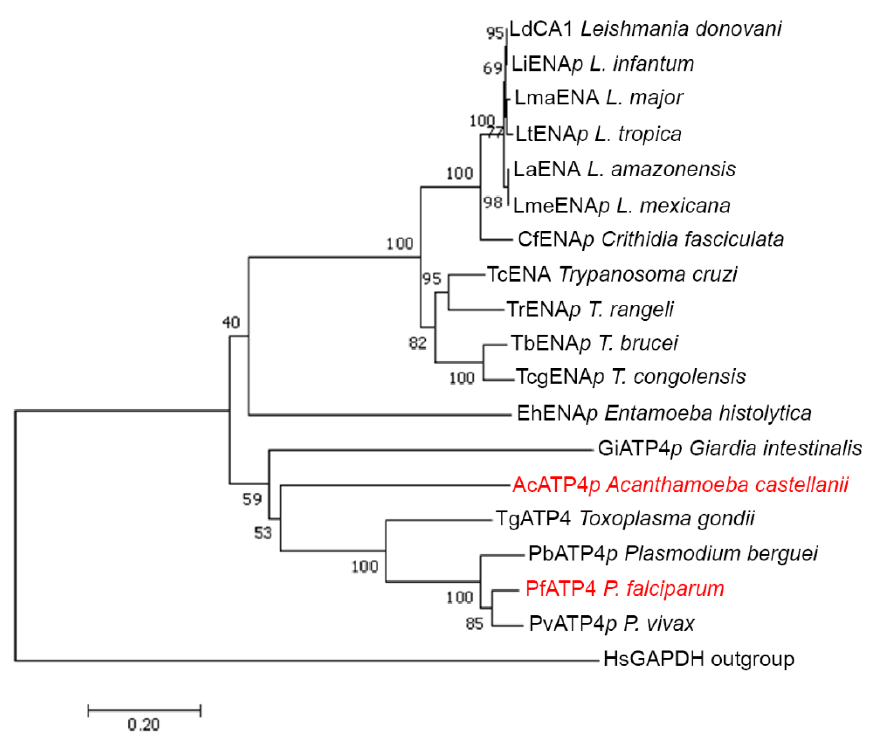
Figure 2. Phylogenetic analysis of Na + -ATPases from protozoan parasites. Amino acid sequences from different unicellular eukaryotic species were aligned, and phylogenetically analyzed with MEGA 5.2.2 software. The ENA ATPase members (with their respective GenBank information) are as follows: